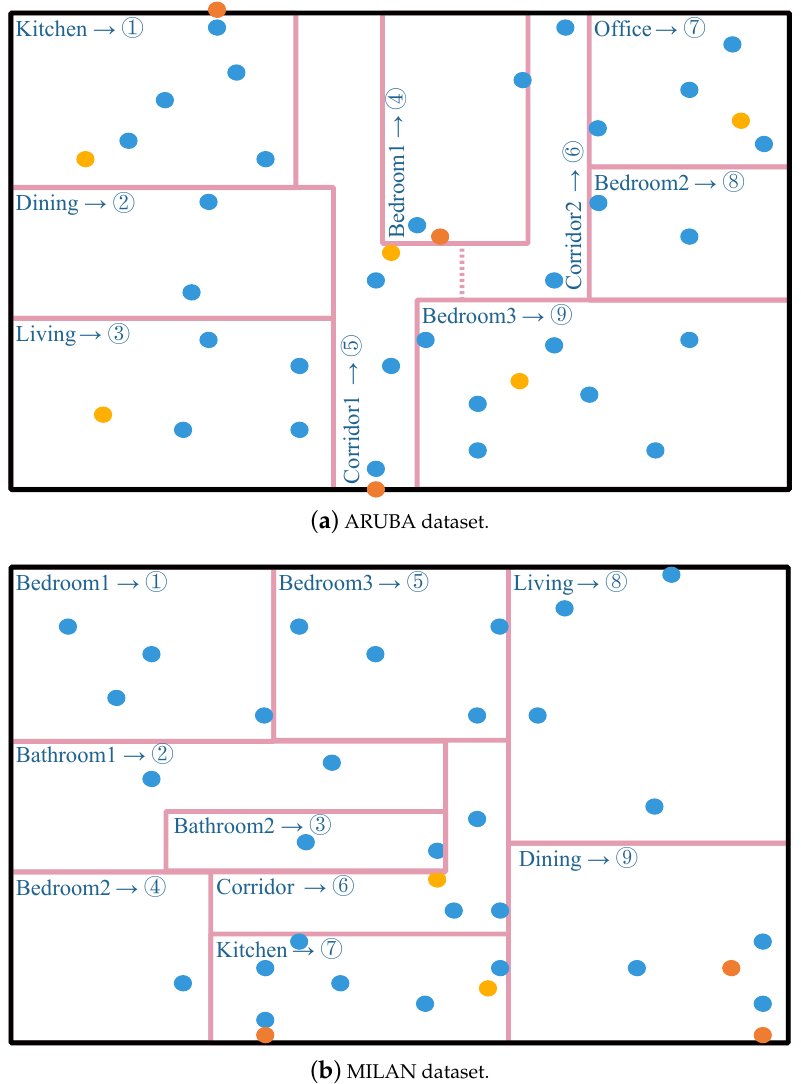
Figure 3. The sensor layout and location definition; blue circles are the motion sensors; yellow circles are the temperature sensors; and orange circles are the door sensors. Arrows indicate that the location indexes of the sensor in the specified area are set to the corresponding